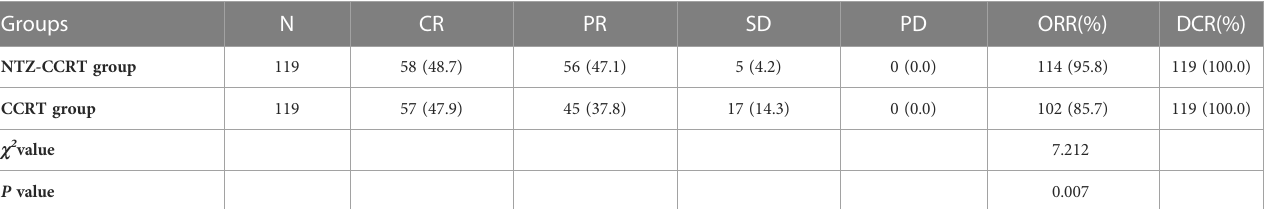
TABLE 2 Comparison of short-term ef fi cacy in nasopharyngeal tumor patients. Groups